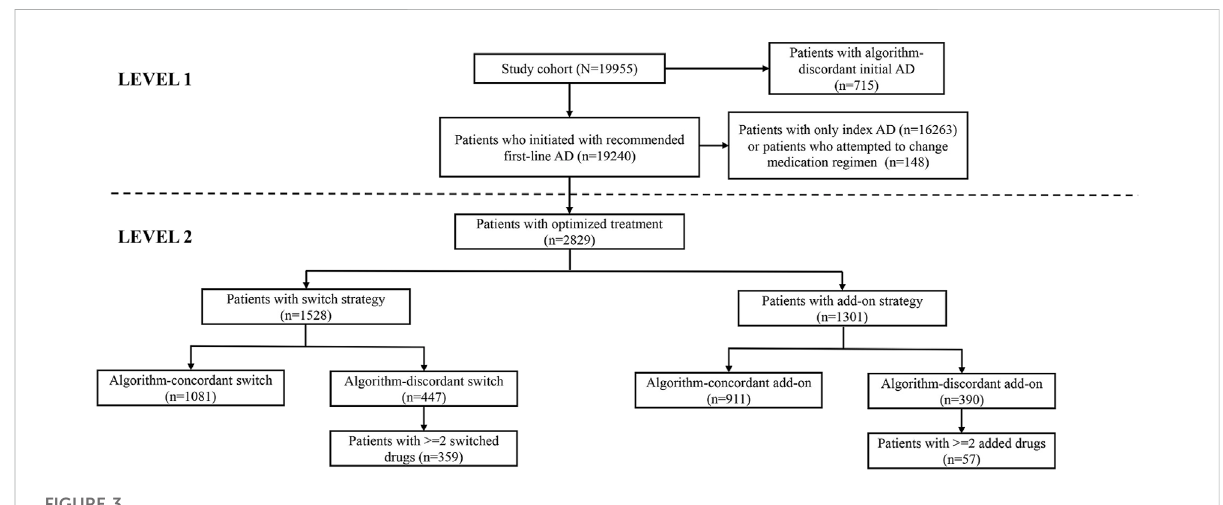
FIGURE 3 Flowchart of the algorithm-discordant practice from level 1 to level 2.